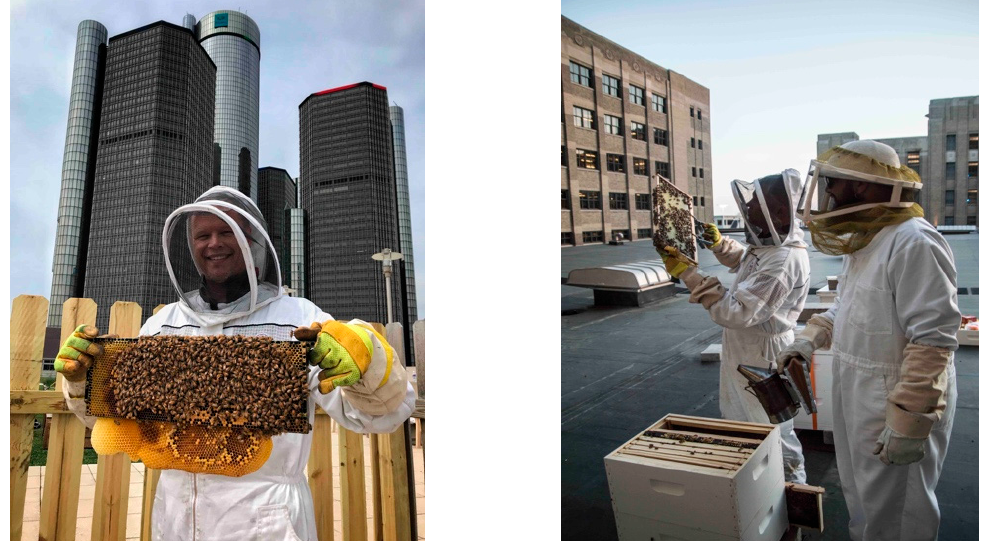
Figure 2. Honey collected from rooftop hives. Photo: Colin McConnell.